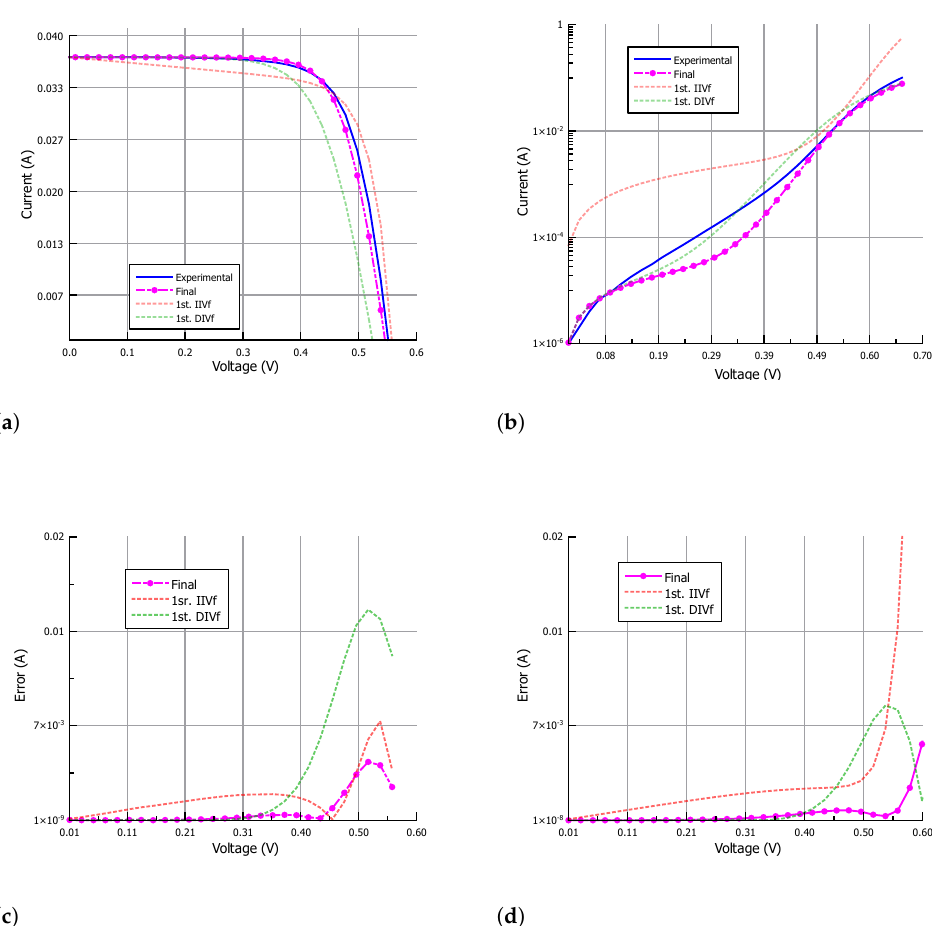
Figure 10. The I-V characteristic approximation of Cell-3 ( a ) under illumination and ( b ) in the dark; and corresponding absolute error ( c ) under illumination and ( d ) in the dark. Results are shown for parameters obtained after the first IIVf subroutine, after the first DIVf subroutine, and at the end of the parameter extraction